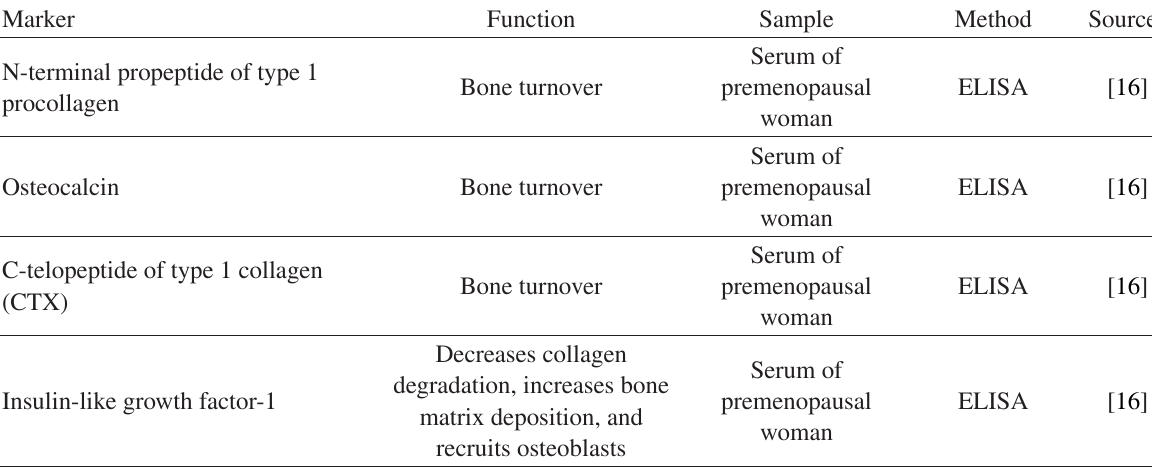
TABLE 2: Markers involved in orthodontic tooth movement collected from